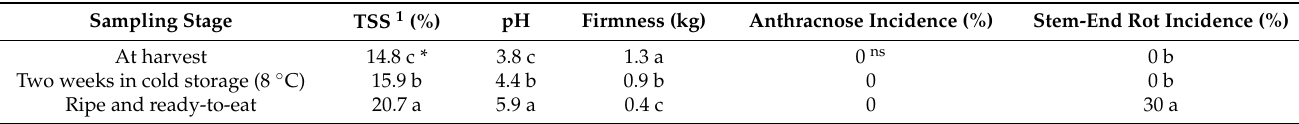
Table 2. Physiological maturity parameters and disease incidence of cv. Tommy Atkins mangoes at the post-harvest stages. Sampling Stage